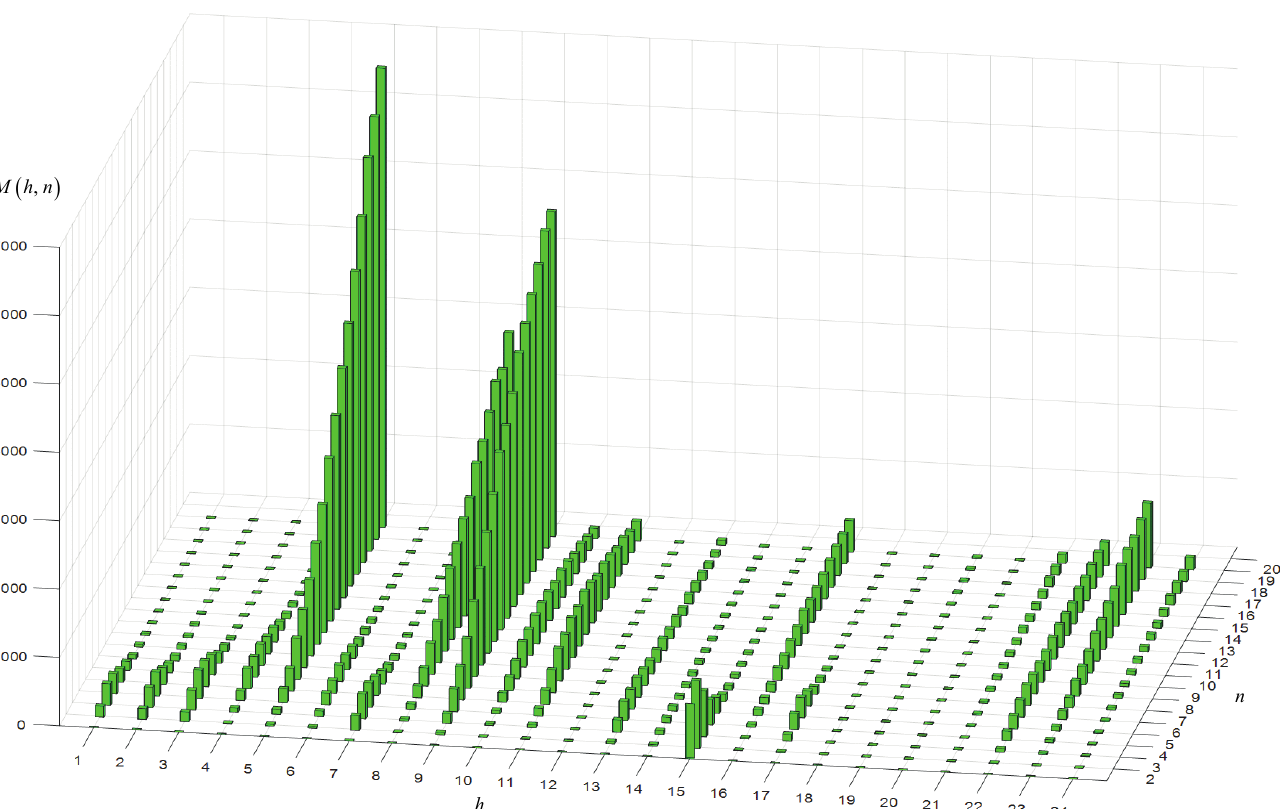
Fig. 6. Distribution of number M ( h , n ) (when the heuristic “wins” solely) per 100 000